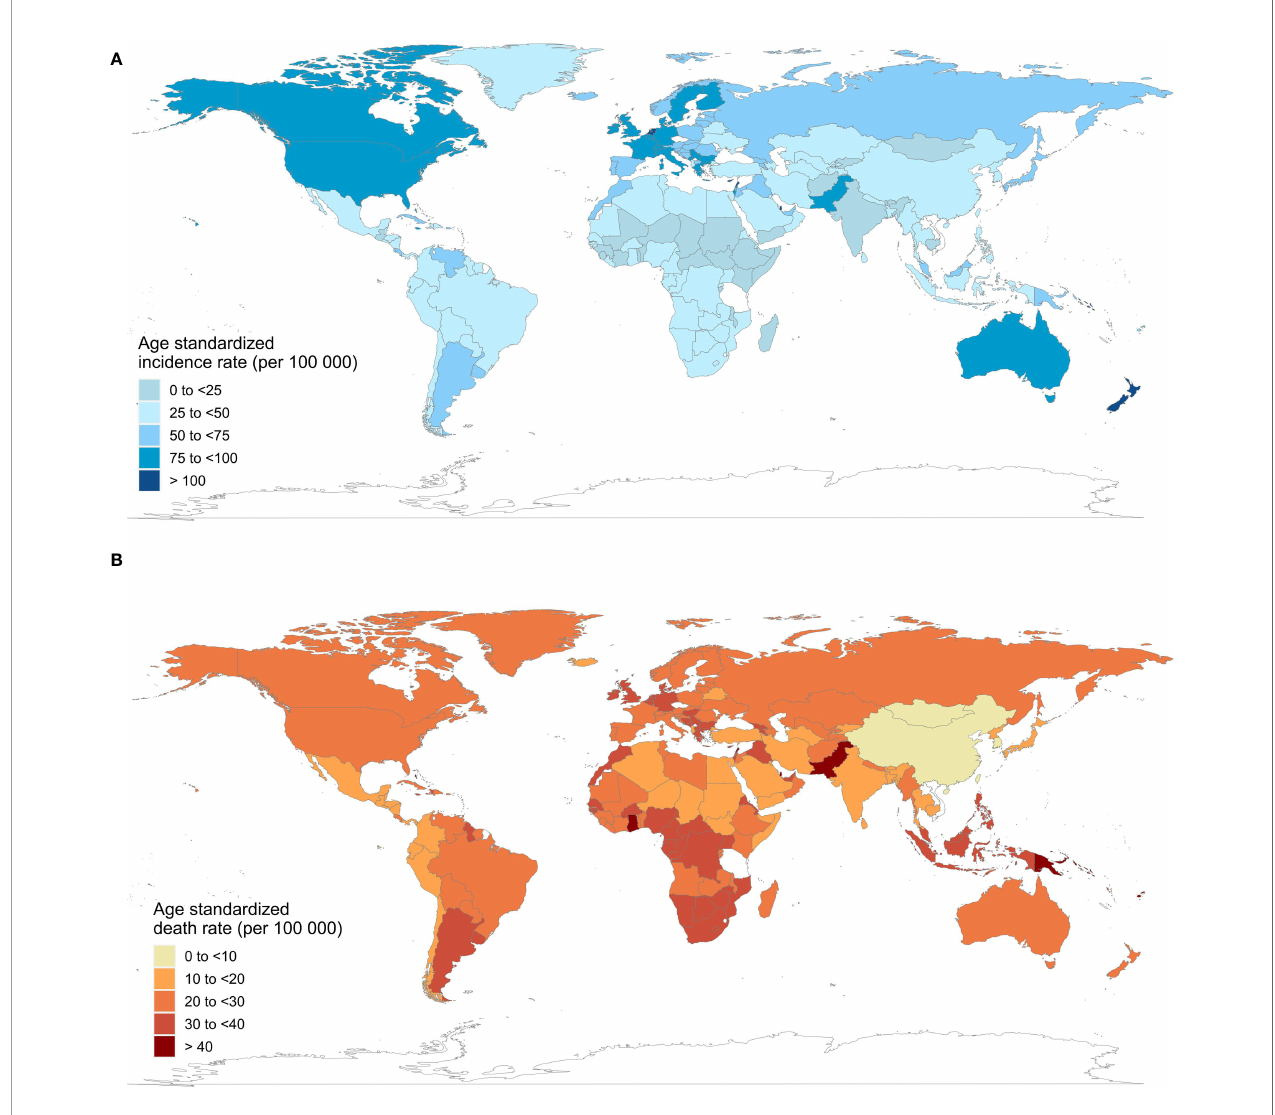
FIGURE 1 | Age-standardized incidence and death rates of female breast cancer in 204 countries and territories, 2019. (A) age-standardized incidence rates; (B) age-standardized death